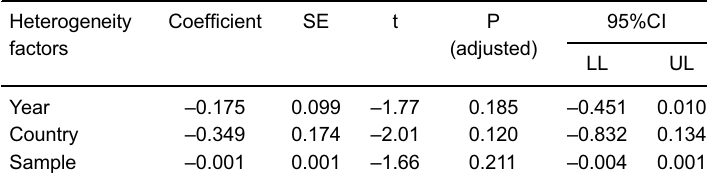
Table 2. Meta-regression analyses of potential sources of